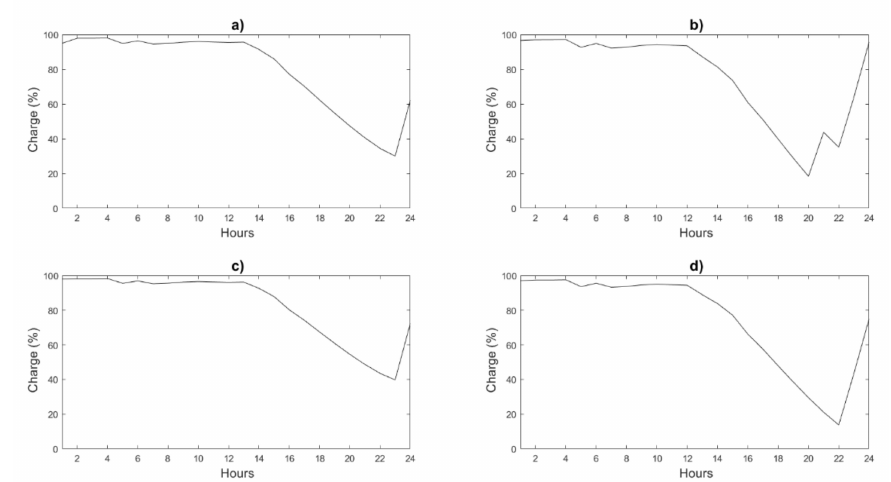
Figure 3. Charging cycle for specific days of the year for the battery-powered systems: ( a ) AC system on 17 June. ( b ) AC system on 16 December. ( c ) Combined AC / DC system on 17 June. ( d ) Combined AC / DC system on 16